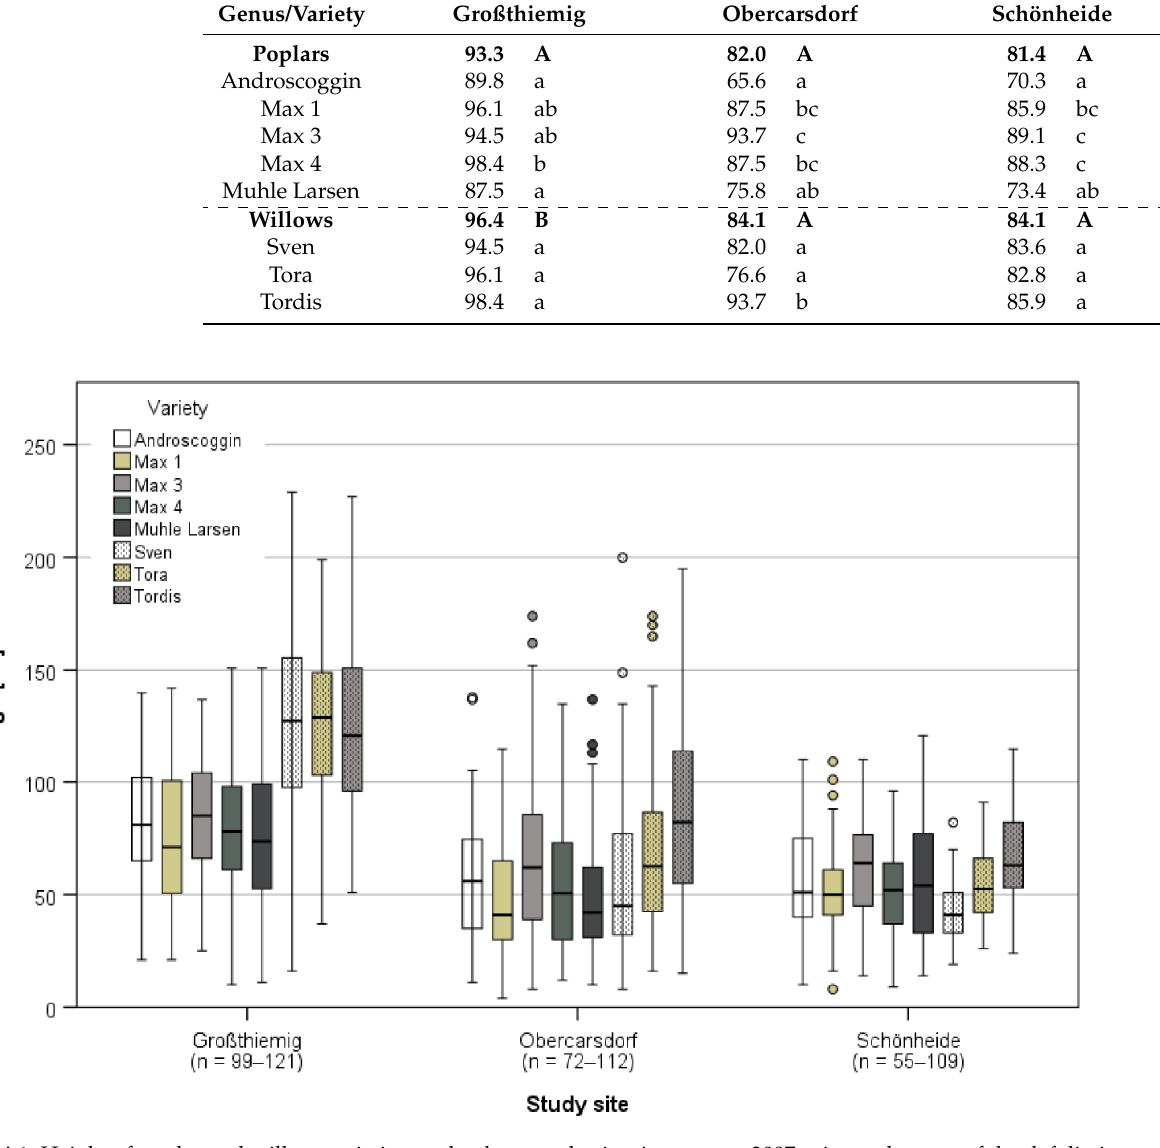
Figure A1. Height of poplar and willow varieties on the three study sites in summer 2007 prior to the start of the defoliation treatments (n = range of number of plants per variety).